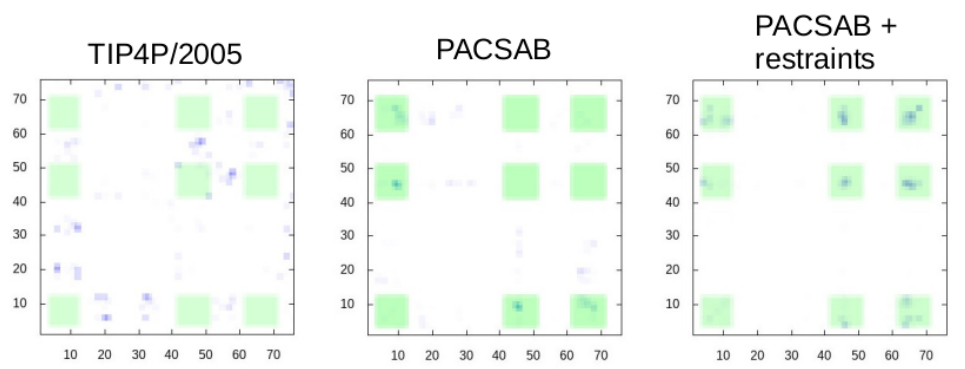
Figure 6. Intermolecular contact maps for the trajectories obtained with explicit solvent MD simula- tion with the TIP4P/2005 water model ( left ), with the optimized PACSAB force field parametrization ( center ) and with the optimized PACSAB force field parametrization and intramolecular restraints ( right ). X,Y axes are the residue number along protein sequence. The regions where contacts are found in the NMR experiments are highlighted in